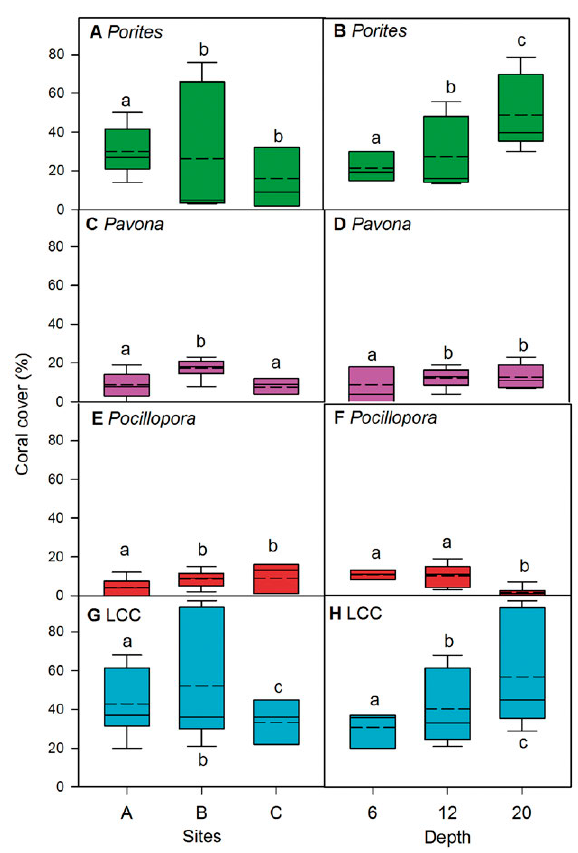
Fig. 3. – Hermatypic coral cover at Clipperton Atoll. Porites cover by site (A) and depth (B). Pavona cover by site (C) and depth (D). Pocillopora cover by site (E) and depth (F). Total live coral cover (LCC) by site (G) and depth (H). In the box and whisker plots, means are dotted lines, 50th percentiles (medians) are solid lines, and boxes correspond to the 25th and 75th percentiles. Error bars mark the 5th and 95th percentiles. The lowercase letters correspond to the Tukey HSD test results.